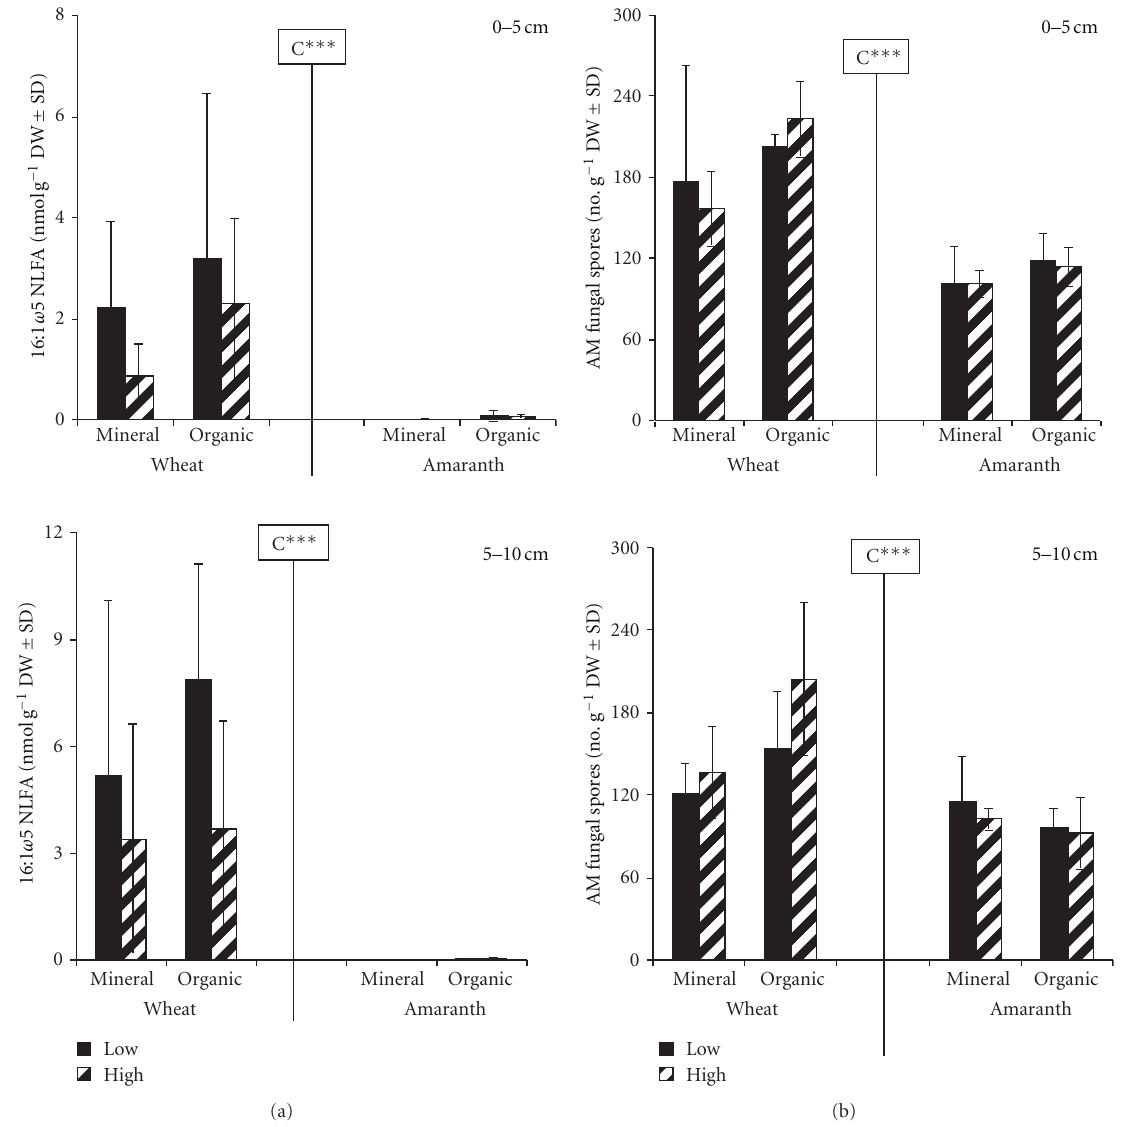
Figure 1: Comparison of microscopic and biochemical estimations of arbuscular mycorrhiza spores in an arable field soil cultivated with wheat or amaranth as crop; 0–5 and 5–10 cm soil depths; amendments with mineral (NPK) and organic (cattle manure + biodynamic preparations) fertilizers applied at low and high amounts; C = crop type; Kruskal-Wallis with ∗∗∗ for P < 0 . 001. (a) AM spores assessed by neutral lipid fatty acid 16:1 ω 5 (nmolg − 1 DW soil ± SD), (b) Spore density counts (No. g − 1 DW soil ±